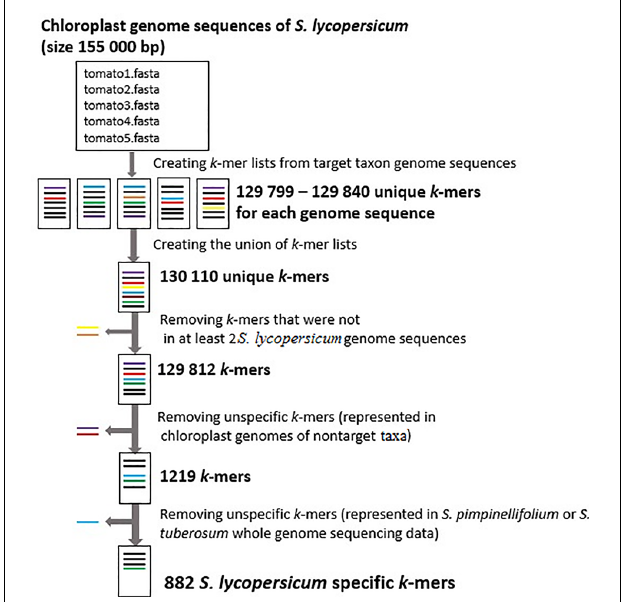
FIGURE 3 | The number of S. lycopersicum k -mers in every step of the pipeline. Each FASTA file contains assembled chloroplast genome sequences from different S. lycopersicum samples. There were 129,799 – 129,840 unique k -mers (32 nucleotides in length) in each chloroplast genome sequence, 130,110 unique k -mers in the union of k -mers from all the sequences and 129,812 k -mers that were present in at least 2 S. lycopersicum chloroplast genome sequences. After removing the k -mers that were not present in at least two target sequences and unspecific k -mers that were present in assembled chloroplast genome sequences of non-target taxa or whole genome sequencing raw reads from Solanum pimpinellifolium and Solanum tuberosum , we detected 882 S. lycopersicum specific k